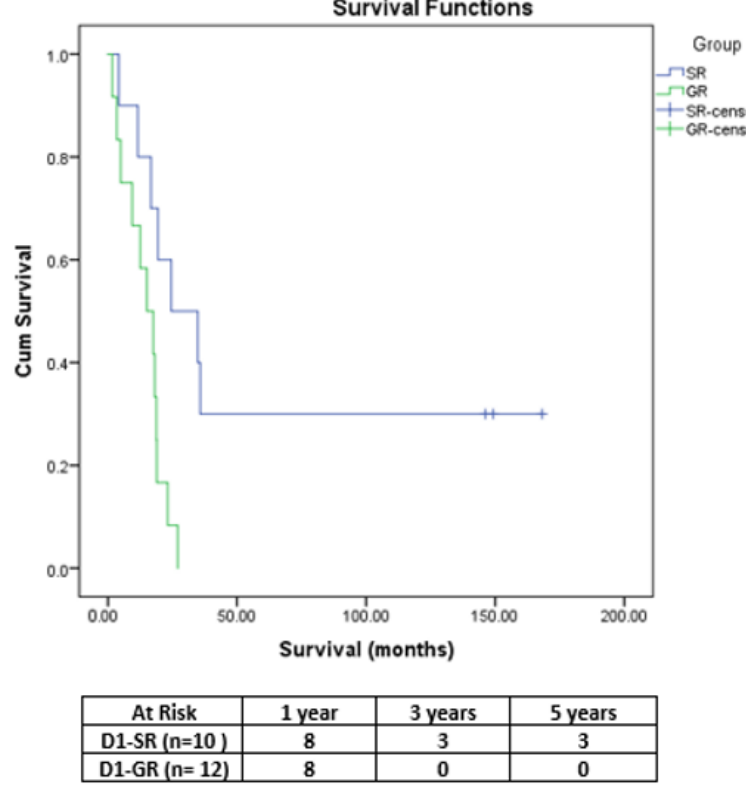
Figure 3. Comparative OS curves in patients with D1 LND (SR group vs. GR group).